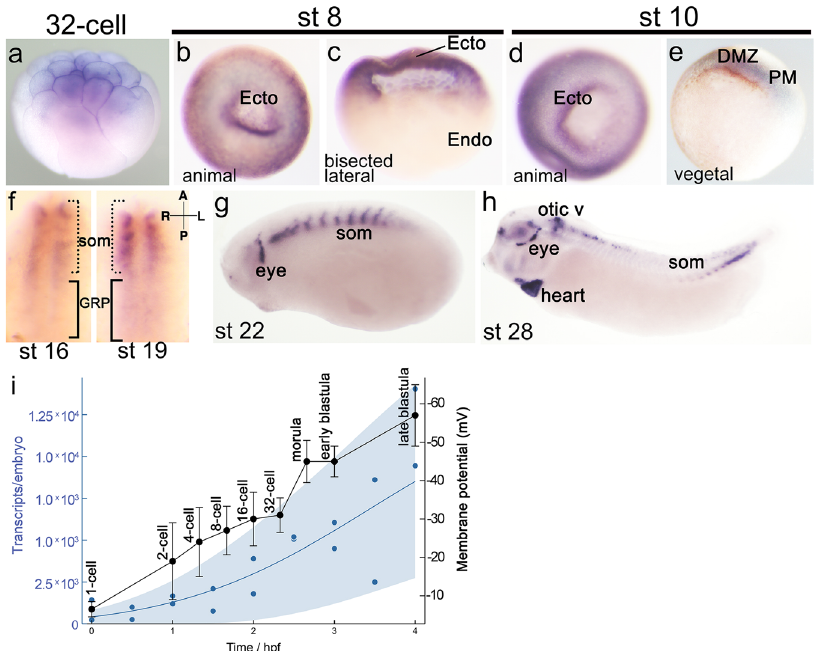
Fig. 2 | kcnh6 expression analysis for kcnh6 during Xenopus development. a – h kcnh6 transcripts were detected by a full-length antisense probe via WMISH. Embryos and tissues displayed are in the following orientations: a animal pole to the top, b animal pole view c bisected with animal pole to the top, d animal pole view, e vegetal view and dorsal to the top, f gastrocoel roof plate with anterior to the top and vegetalview, g , h lateralview withanterior to the left anddorsaltothe top; Ecto prospective ectoderm, Endo prospective endoderm, DMZ dorsal mar- ginalzone (mesoderm), PMparaxial mesoderm, somsomites, GRPgastrocoelroof